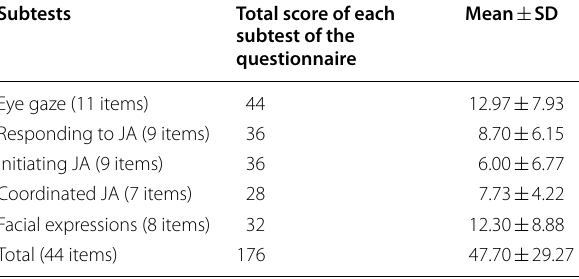
Table 3 Raw scores of the questionnaire items in group II of autistic